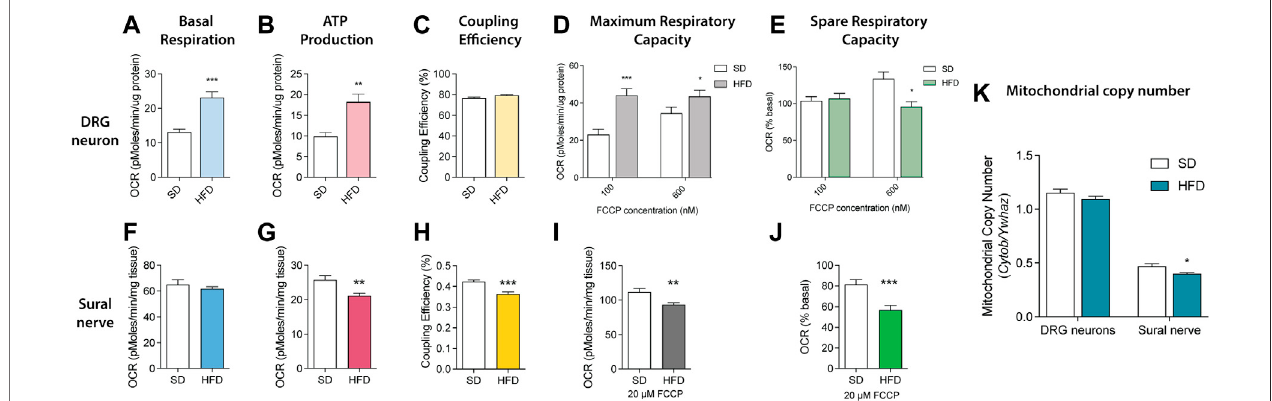
FIGURE8| MitochondrialbioenergeticsinSDvsHFDDRGneuronsandsuralnerves.Restingbioenergeticsparametersincluding (A) basalrespirationand (B) ATP production were signi fi cantly increased in DRG neurons from HFD mice compared to SD mice, whereas (C) coupling ef fi ciency was unaffected. (D) HFD DRG neurons challenged with 100 and 600 nM FCCP had increased maximum respiratory capacity, but signi fi cantly diminished spare respiratory capacity with 600 nM FCCP (E) relativetoSDDRGneurons.TheHFDhadnoeffectonsuralnerve (F) basalrespirationbutsigni fi cantlyreducedboth (G) ATPproductionand (H) couplingef fi ciency comparedtotheSDsuralnerve.ChallengingtheHFDsuralnervewith20 μ MFCCPsigni fi cantlyimpairedboth (I) maximumrespiratorycapacityand (J) sparerespiratory capacity compared to SD sural nerves. (K) Mitochondrial copy number was reduced in HFD sural nerve. Data mean ± SEM, n = 15 mice/group sural nerves; * p < 0.05, ** p < 0.01, *** p <